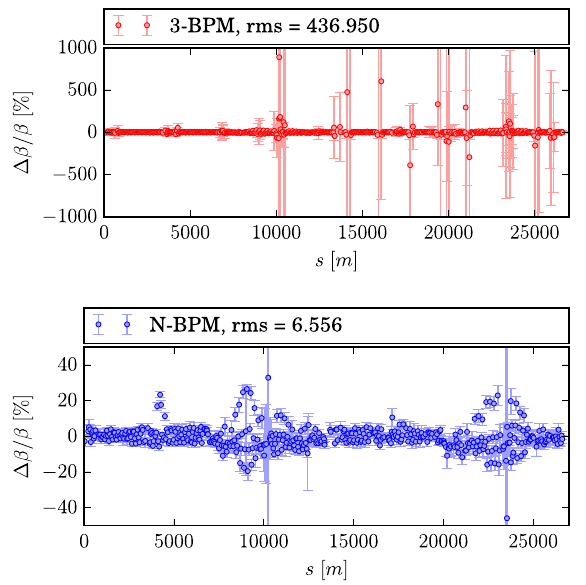
FIG. 6. Same comparison of Fig. 5 between the three methods for the HL-LHC β (cid:1) ¼ 15 cm ATS optics. The analytical N-BPM method yields clearly better results, both in the IRs and in the arcs. Compared to the β (cid:1) ¼ 40 cm optics shown in Fig. 5, the β function reconstruction is less accurate: This was also demon- strated for the β (cid:1) ¼ 20 cm optics in [4].